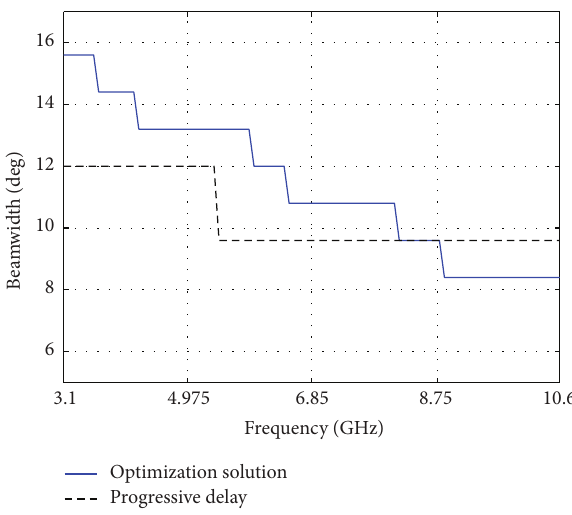
Figure 6: Comparison of the maximum SLL of the power pattern in each frequency in the UWB spectrum for the optimized solution and the conventional case.